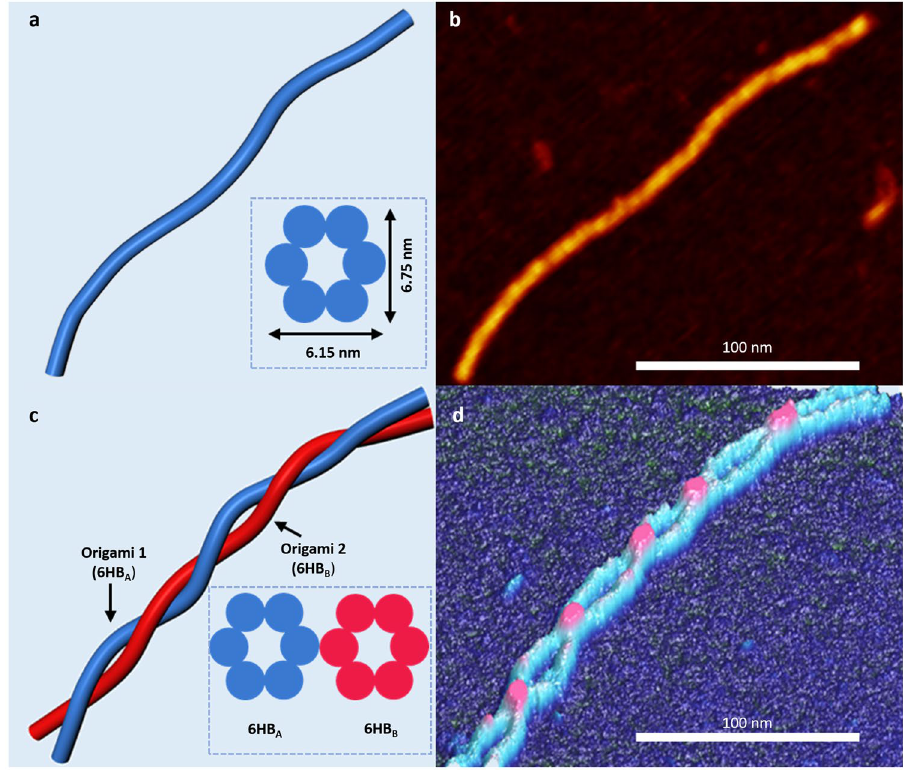
Figure 1. Schematic ( a ) and AFM image ( b ) of a DNA origami six-helix bundle (6HB). Inset in ( a ) illustrates the cross section of the bundle. Schematic ( c ) and AFM image ( d ) of a DNA nanorail twisting with left-handed chirality. Twisting was caused by ethidium bromide. Inset in ( c ) illustrates the nanorail cross